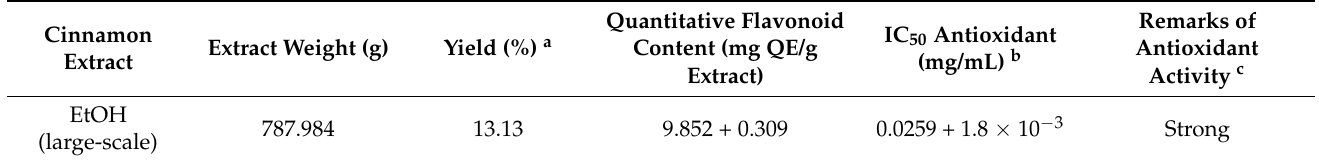
Table 3. Yield, quantitative flavonoid content, and antioxidant activity of large-scale EtOH extract of cinnamon.